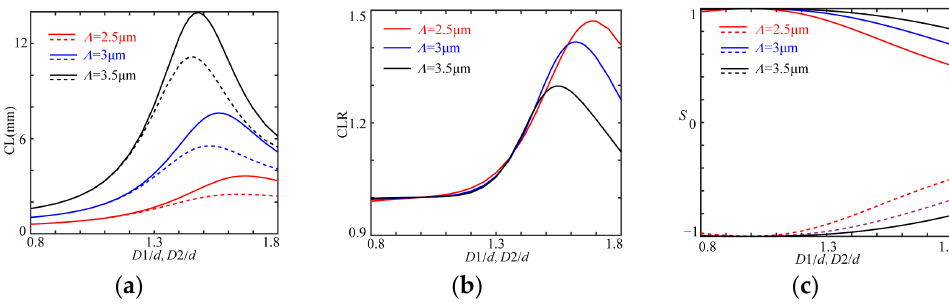
Figure 6. The variation relations of CLs ( a ), CLRs ( b ) and S s ( c ) with D 1/ d and D 2/ d